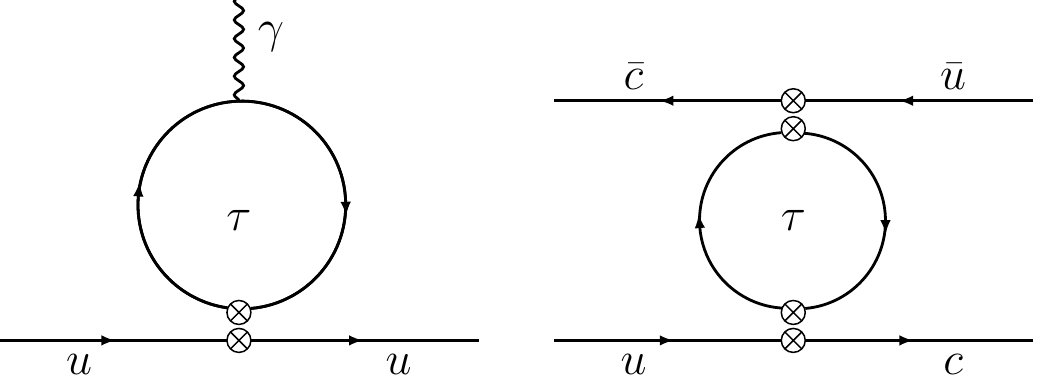
Figure 4 . Diagrammatic representations of the electromagnetic dipole operator contributing to the neutron EDM induced by inserting the operator (¯ τ L σ µν τ R )(¯ u L σ µν u R ) (left), and the ∆ C = 2 four-quark operators contributing to the D 0 − ¯ D 0 mixing produced by a double insertion of the operator (¯ τ L σ µν τ R )(¯ c L σ µν u R ) (right, and its permutation should also be taken into account).